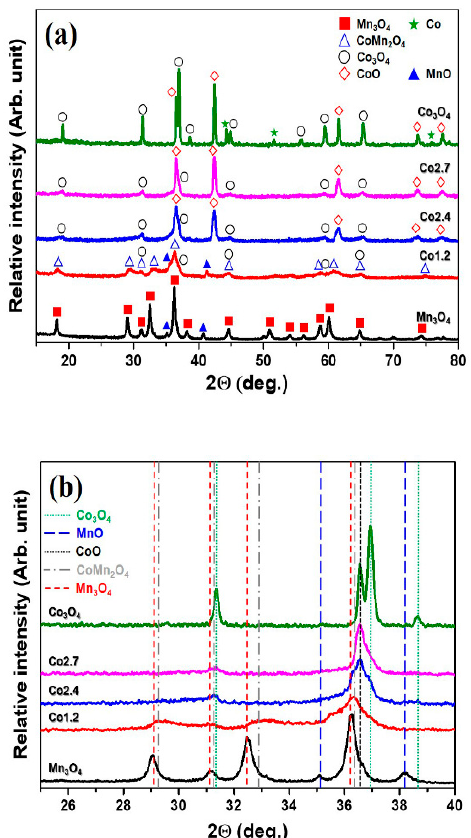
Figure 3. ( a ) XRD patterns of Co- and Mn-based the mixed phase materials (Co = 0, 1.2, 2.4, 2.7, and 3) and ( b ) enlarged XRD patterns in 2 θ range of 25–40°.